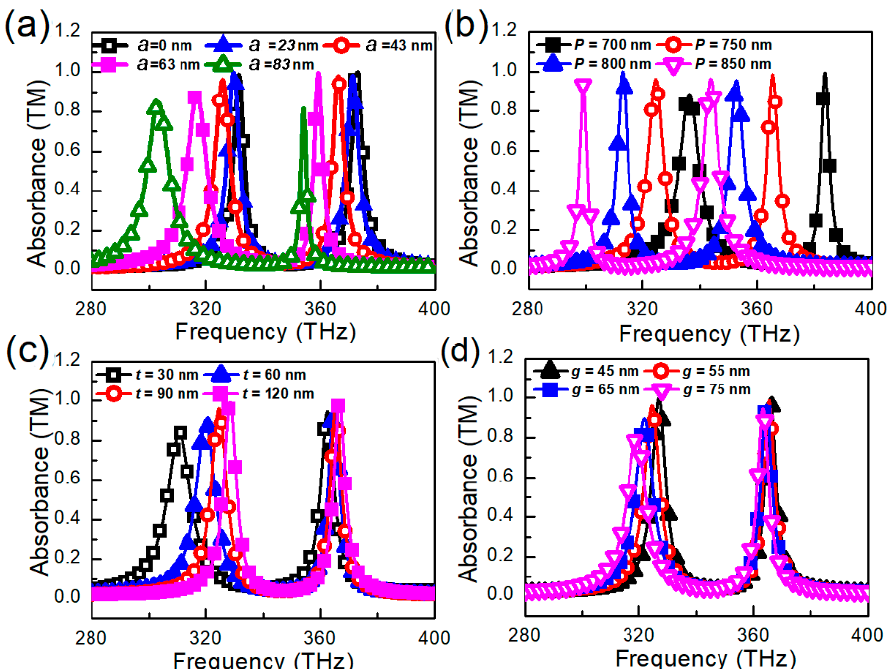
Figure 6. Absorbance spectra based on the radius a ( a ), period p ( b ) thickness t ( c ), and elliptical slit gap g ( d ) of perfect absorber for TM-polarized wave.